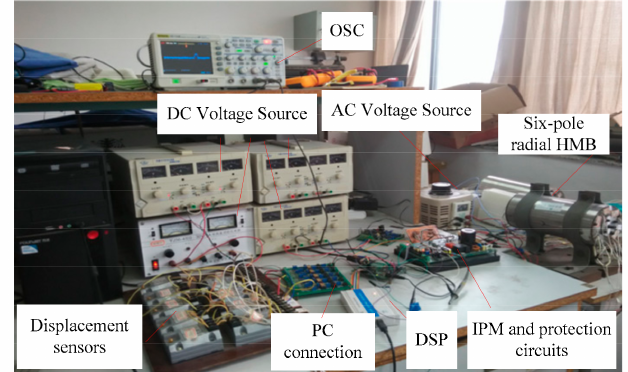
Figure 8. Experiment